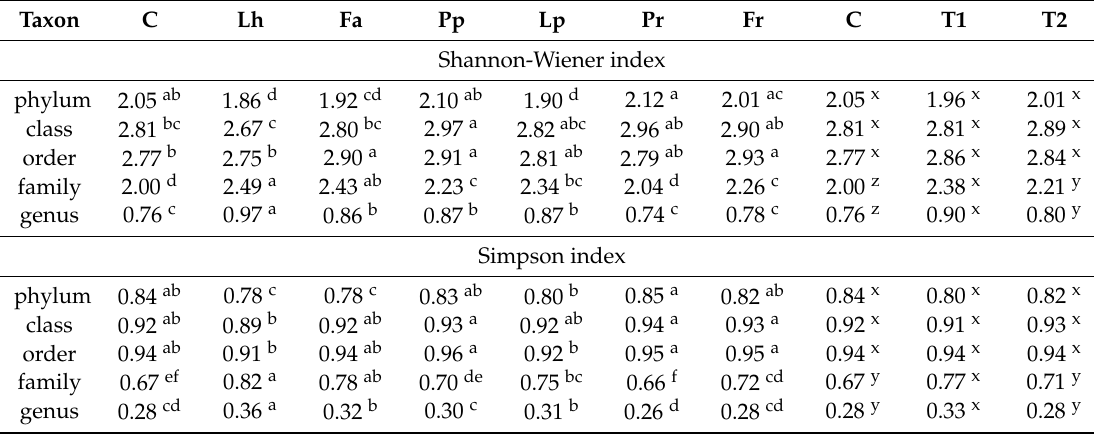
Table 4. Shannon and Simpson indices calculated from abundance of OTU.